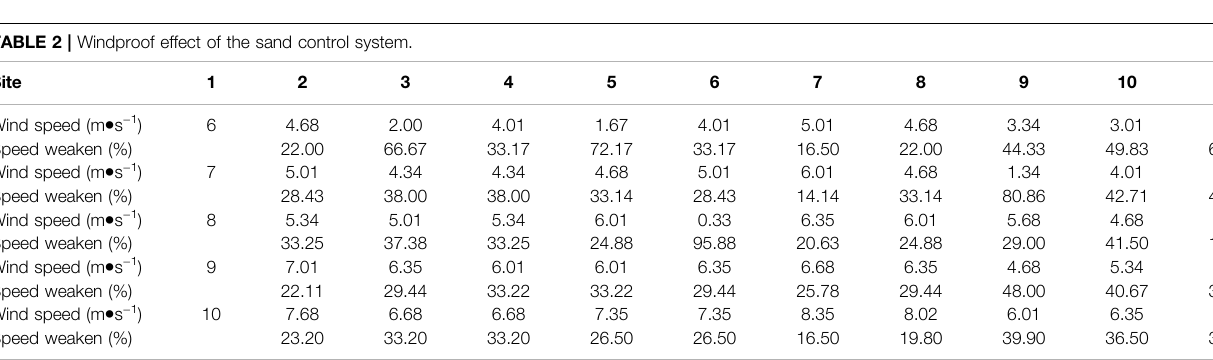
TABLE 2 | Windproof effect of the sand control system.